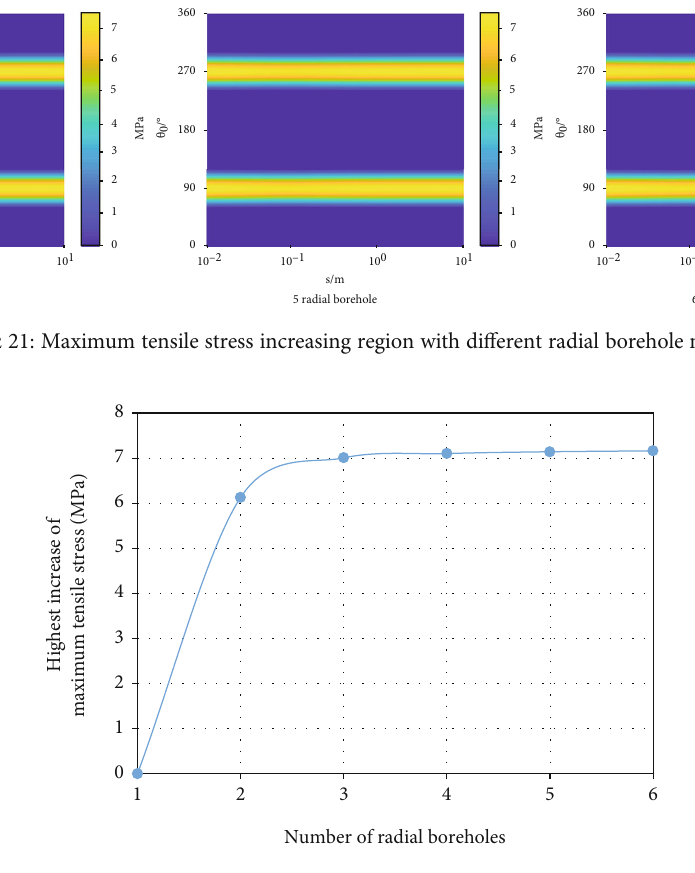
Figure 22: Highest increment of maximum tensile stress with di ff erent radial borehole